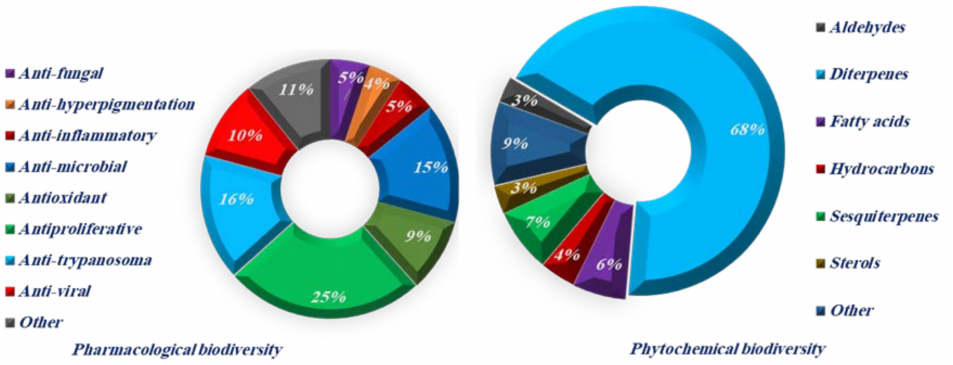
Figure 12. Pharmacological and phytochemical biodiversity of Dictyota